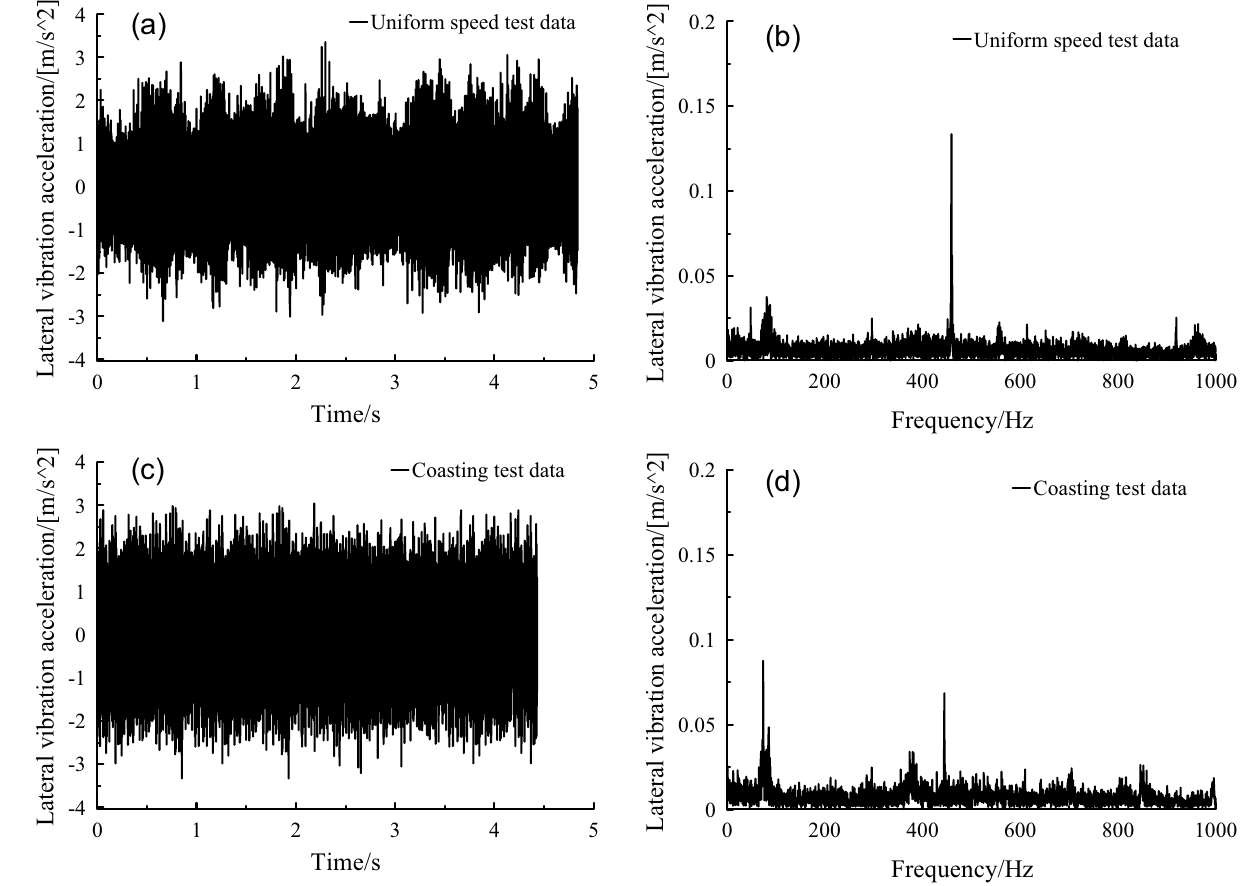
Figure 6. Frame lateral vibration acceleration, at (a-b) uniform speed, and (c-d) coasting